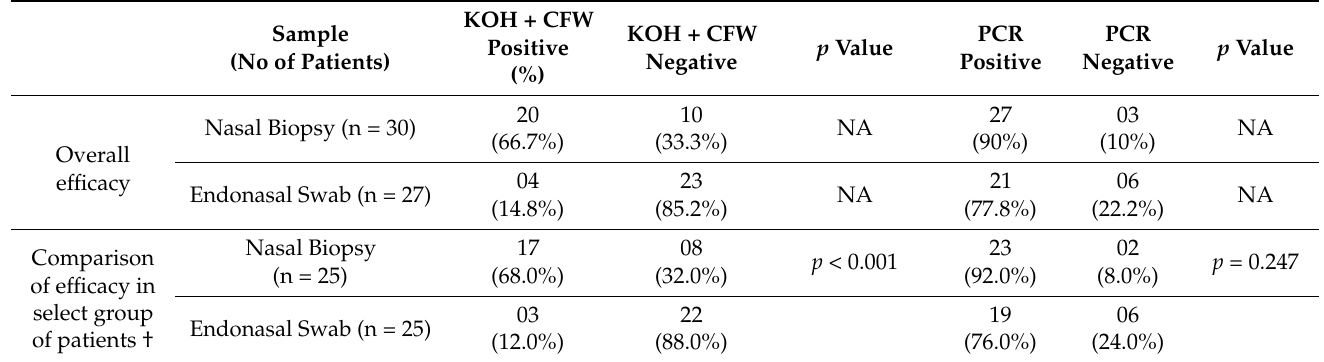
Table 3. Comparision of the efficacy of Endonasal swab and Nasal Biopsy in detecting fungal isolates in ROCM